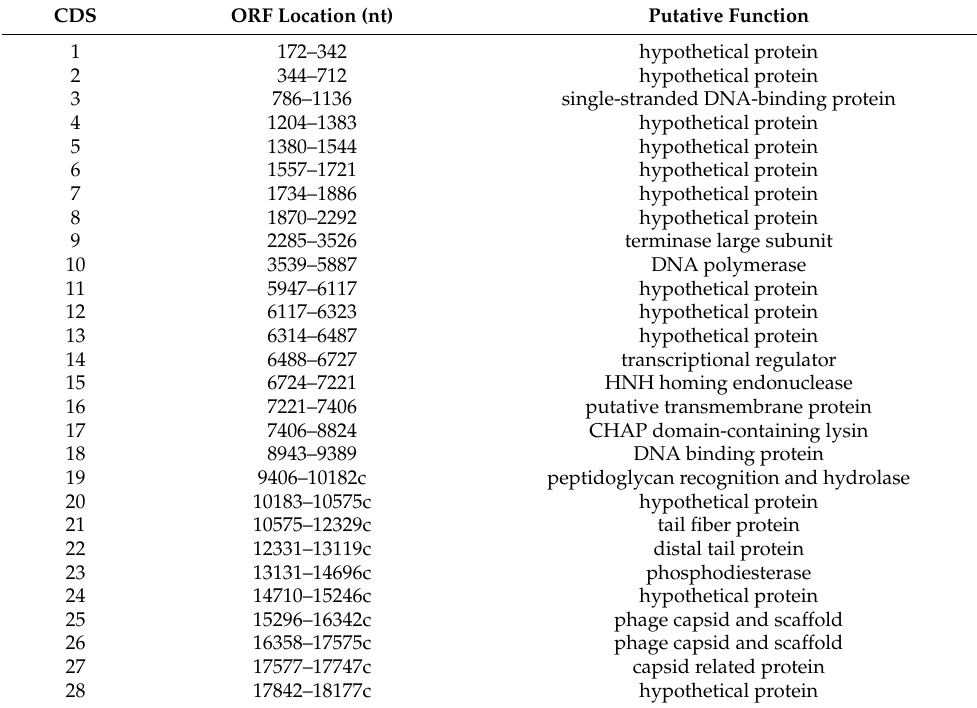
Nucleotide locations with suffix c indicate the reading frame is located on the complementary